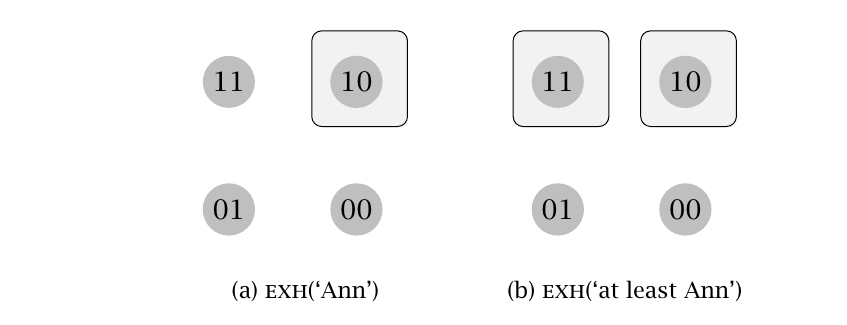
Figure 4 Exhaustification of two propositions with respect to ‘Who